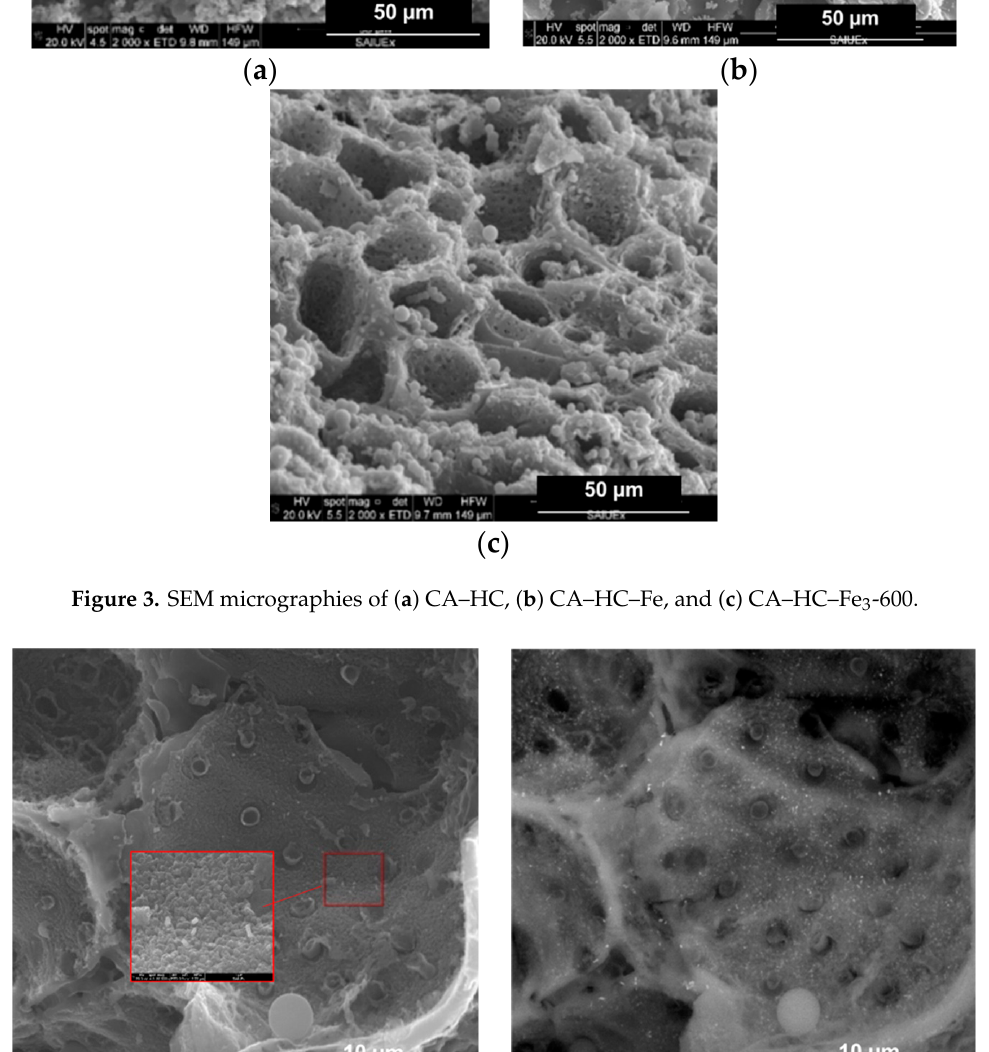
Molecules 2019 , 24 , x 7 of 13